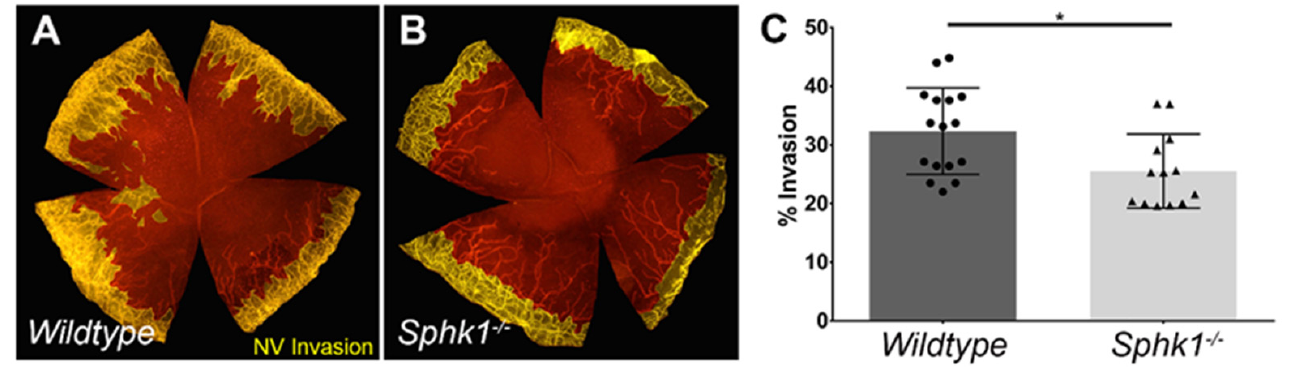
Figure 3. Ablation of Sphk1 reduce corneal neovascularization following alkali burn. Mice corneas were stained ten days post alkali burn with CD31 ( red ) to visualize vasculature. Representative im- age in pseudo-color ( yellow ) showing neovascular invasion in ( A ) WT ( n = 16) and ( B ) Sphk1 − / − ( n = 15). ( C ) Quantitation of percent neovascular invasion into the cornea. (Values are mean ± SD, * p ≤ 0.05).